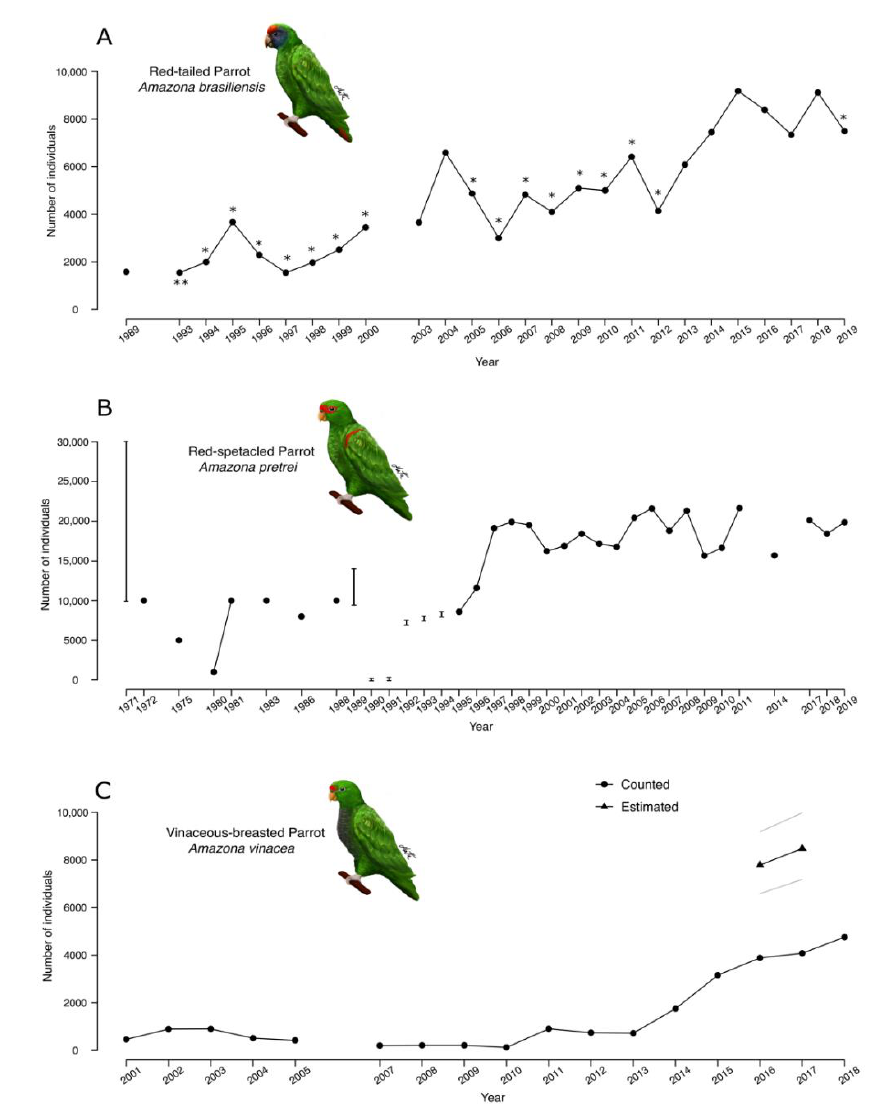
Figure 3. Number of Red-Tailed ( A ), Red-Spectacled ( B ), and Vinaceous-Breasted ( C ) Parrots counted by research teams throughout the last fifty years. Panel ( C ) also includes two estimates of the Vinaceous-Breasted Parrot population size, with gray lines showing bounds of the 95% credible interval of the a posteriori distribution of population size. These are the only statistical estimates of population size available in the literature for any of the study species. There is no plot for the Red-Browed Parrot because we could not find published records of count results for this species. Some of the Red-Spectacled Parrot counts were reported as intervals and appear as vertical lines in panel ( B ). Variations in the number of counted individuals may be due to variation in sampling effort or to real change in population size. Asterisks in panel ( A ) show differences in sampling effort: * corresponds to years that the counts were performed only in Paran á , and ** only in S ã o Paulo. Sources for the numbers shown are [28,29,43–61] ( A ), [36–42,67] ( B ), and [21,27,42,62–64] ( C